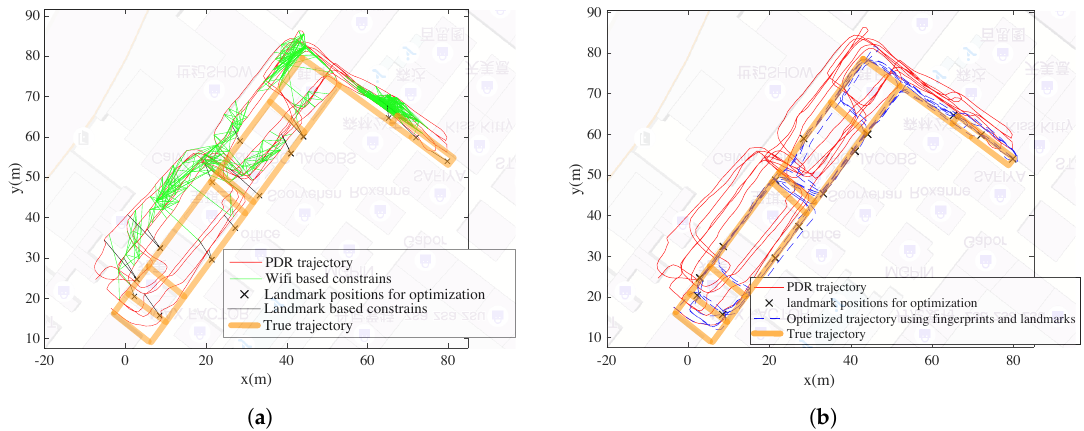
Figure 10. Results for fusing PDR trajectory, Wifi fingerprints and landmark positions. ( a ) Wifi based and landmark based constraints. ( b ) Optimized trajectory.